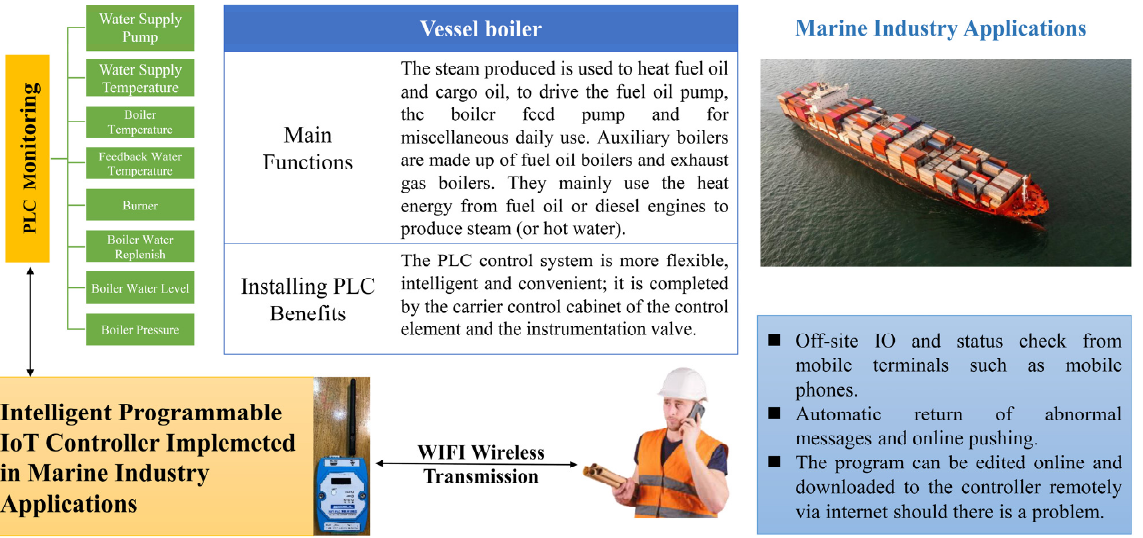
Figure 13. IoT Application Scenario for Vessel Boiler in Marine Industry